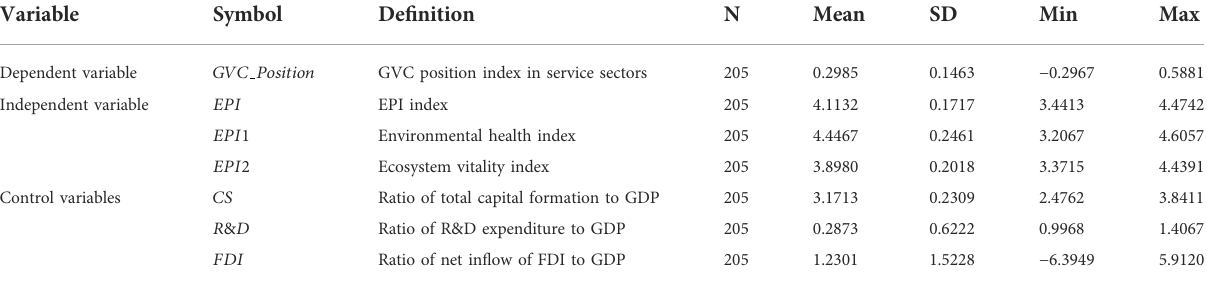
TABLE 2 Descriptive statistics of